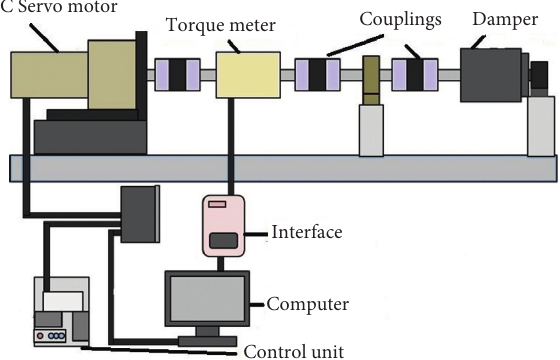
Figure 3: Schematic diagram of experimental